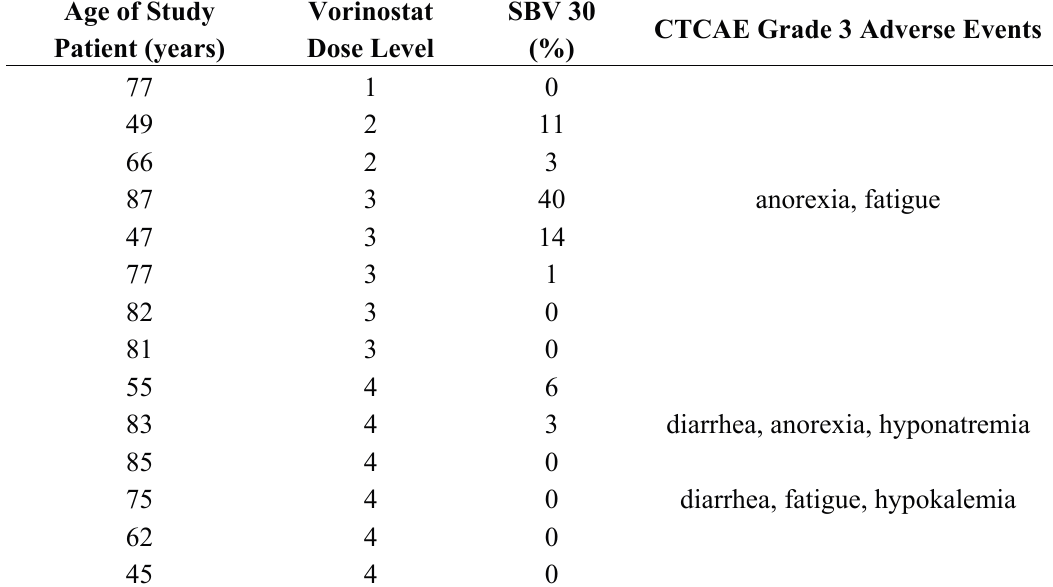
Table 2. Pelvic Radiation and Vorinostat: individual study patient’s age, vorinostat dose level, relative small bowel volume receiving the fully prescribed radiation dose of 30 Gy (SBV 30), and reported Common Terminology Criteria for Adverse Events (CTCAE) grade 3 intestinal